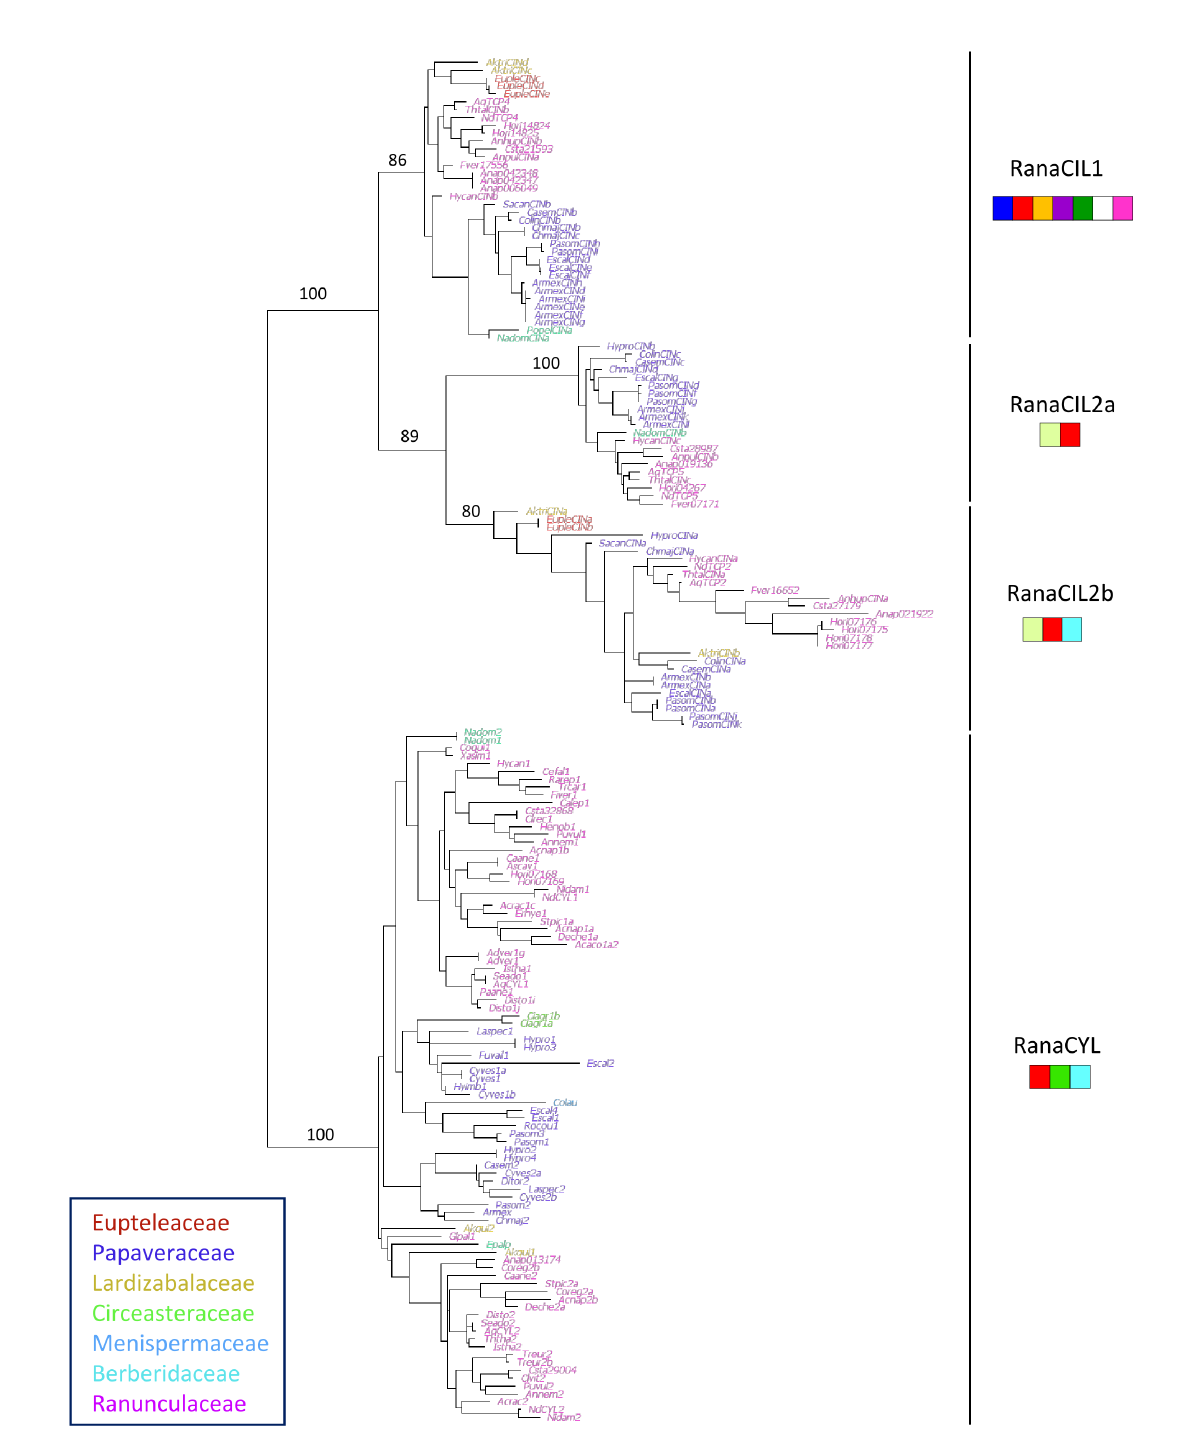
FIGURE 4 Phylogeny of 173 class II TCP coding sequences from Ranunculales. Ranunculales families were color-coded as indicated. Support values (a-LRT x100) are given for the main branches, corresponding to clades identi fi ed in Figure 2. The speci fi c combinations of amino acid motifs that characterize the four clades are drawn under each clade name. A motif is represented if it is found in more than half of the sequences in that clade. Red: M II R 1; light blue: M II R 2; mid green: M II R 3; violet: M II R 4; yellow: M II R 5; dark green: M II R 6; dark blue: M II R 7; pink: M II R 8; white: M II R 9; yellow green: M II R 10 (motifs de fi ned in Supplementary Figure